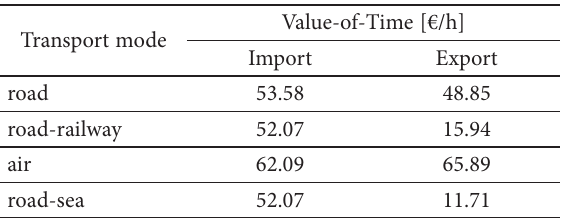
Table 12. Direct elasticity of commodity with respect to travel cost increasing (+5%) Transport